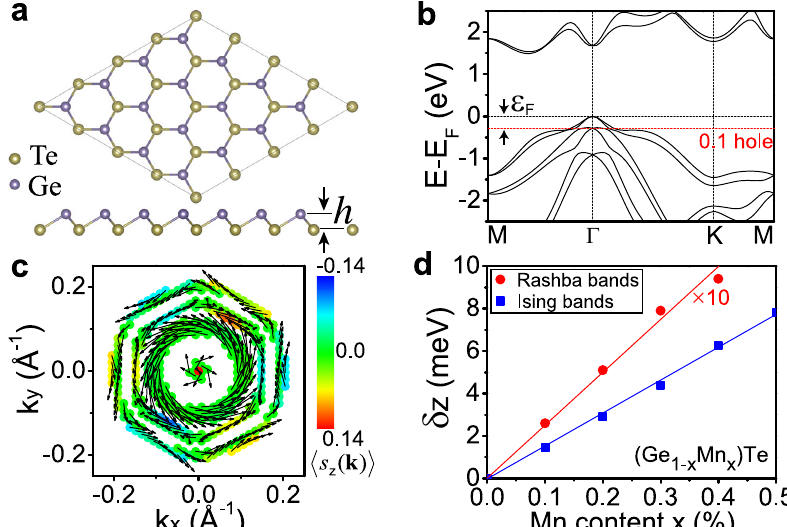
Fig. 1 Crystal structure and electronic property. a The top and side view of GeTe monolayer and ( b ) its electronic band structure. The black horizontal dashed line represents the Fermi level and the red one is the Fermi level after doping 0.1 holes per primitive cell, corresponding to the hole doping concentrations of ~7.4 × 10 13 cm − 2 . c The electronic spin-texture on the FS of 0.1-hole-doped GeTe monolayer. d The Zeeman gaps ( δ z ) of the Rashba/Ising bands opened at the Γ point versus the concentration x of Mn dopants with high-spin state. The δ z of the Rashba bands are magni fi ed by ten times for clarity. The red and blue lines are the linearly fi ttings of δ z